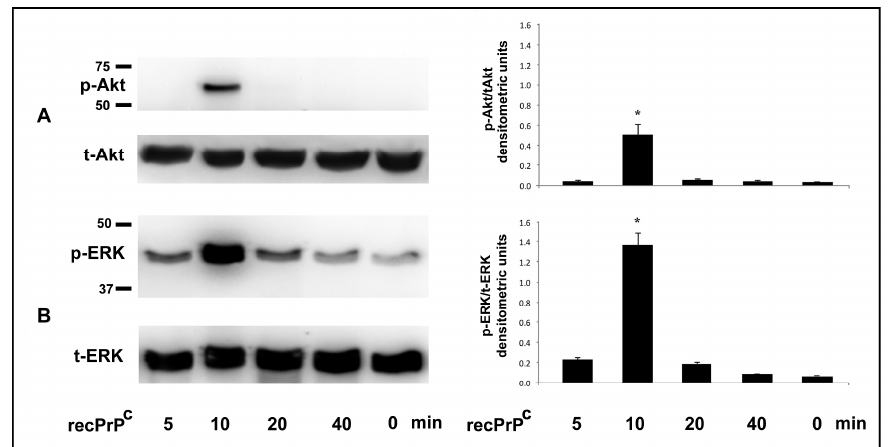
Figure 1. Effect of recPrP C on Akt and ERK Phosphorylation. hDPSCs, untreated or treated with 0.5 µg/mL of recPrP C for 5, 10, 20, 40 min, were analyzed by Western blot using anti-pAkt, anti-total Akt ( A ), anti-pERK1/2 and anti-total ERK1/2 ( B ). Densitometric analysis is shown in the right panel. Results represent the mean ± SD from 3 independent experiments, * p recPrP C treated cells <0.01 vs. untreated cells.